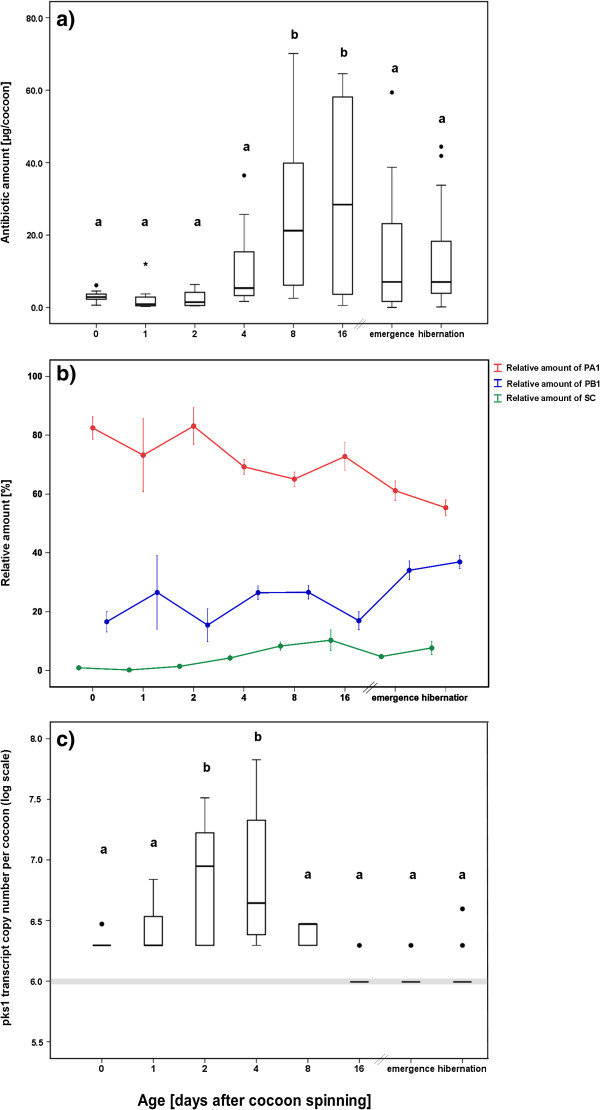
Dynamics of antibiotic production on beewolf cocoons. a) Total amount [μg/cocoon] of antibiotic substances on beewolf cocoons at different time points after cocoon spinning quantified using GC-MS. Different letters above the boxes represent significant differences (ANOVA with Tukey post-hoc tests: df=7, p<0.001), b) Average relative amounts of the three most abundant antibiotic substances on beewolf cocoons (in %) at different time points after cocoon spinning quantified by GC-MS. A discriminant analysis based on the composition of the antibiotic cocktail correctly classified 20–72.2% of the originally grouped cases (40.1% on average, Wilks’ Lambda: 0.432, Chi2: 126.4, df=21, p<0.001, see Additional file
1: Figure S1), c) Absolute number of putative piericidin transcripts (pks1) on beewolf cocoons at different time points after cocoon spinning, obtained from RT-qPCR assays (on log scale). Different letters above the boxes represent significant differences (ANOVA with Tukey post-hoc tests: df=7, p<0.001). The different groups refer to days after cocoon spinning; emergence: eclosion of adult beewolf from the cocoon (about four weeks after cocoon spinning), hibernation: eclosion after diapause (about 8 months after cocoon spinning). Bold lines represent medians, boxes comprise the interquartile range, bars indicate minimum and maximum value, outliers are given as dots; the grey bar indicates the level of unspecific amplification as obtained from the qPCR negative control.